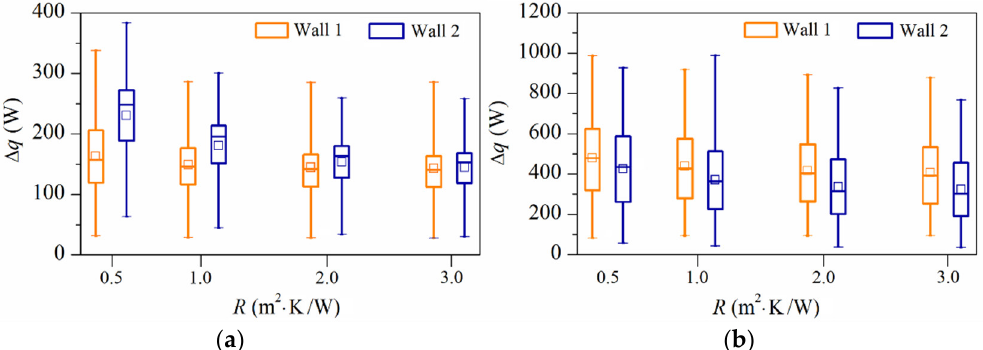
Figure 12. Boxplot of the daily peak-valley load difference for different thermal resistance; ( a ) in cooling season; ( b ) in heating season.